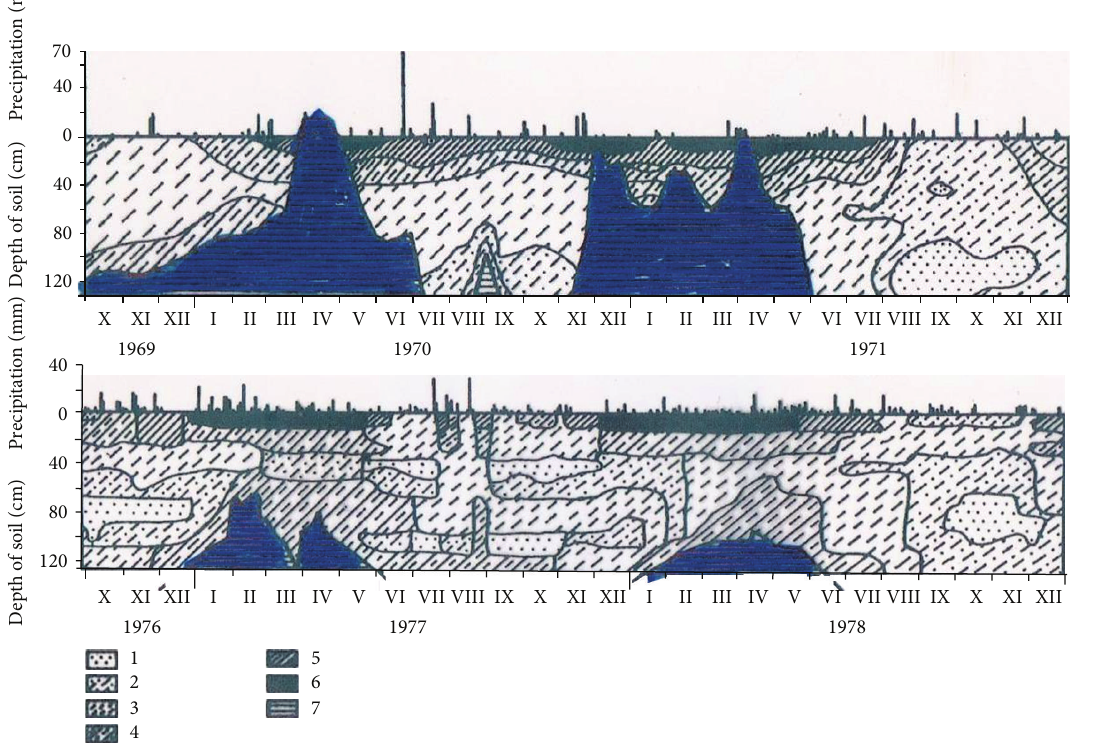
Figure 2: The dynamics of soil moisture (chronoisopleths) measured on research site in a period of floods (1969–1971) and in a period without floods (1976–1978). Soil moisture in percent by volume (1) 25–30, (2) 30–35, (3) 35–40, (4) 40–45, (5) 45–50, (6) 50–55, and (7) groundwater